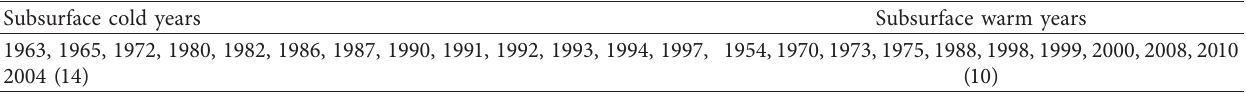
Table 2: Mean TCF generated during JASON season in the subsurface warm year and cold year.